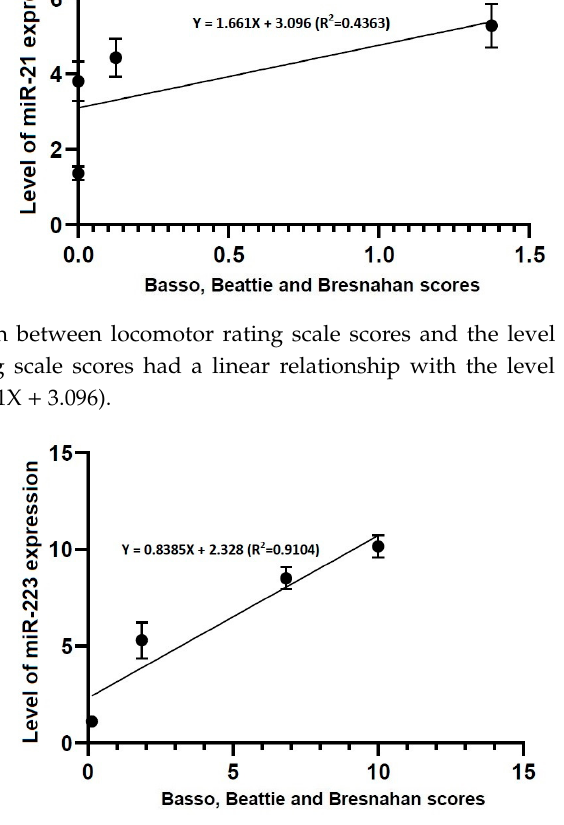
Figure 7. Correlation between locomotor rating scale scores and the level of miR-223 expression. The locomotor rating scale scores had a linear relationship with the level of miR-223 expression (R 2 = 0.9104, Y = 0.8385X + 2.328).